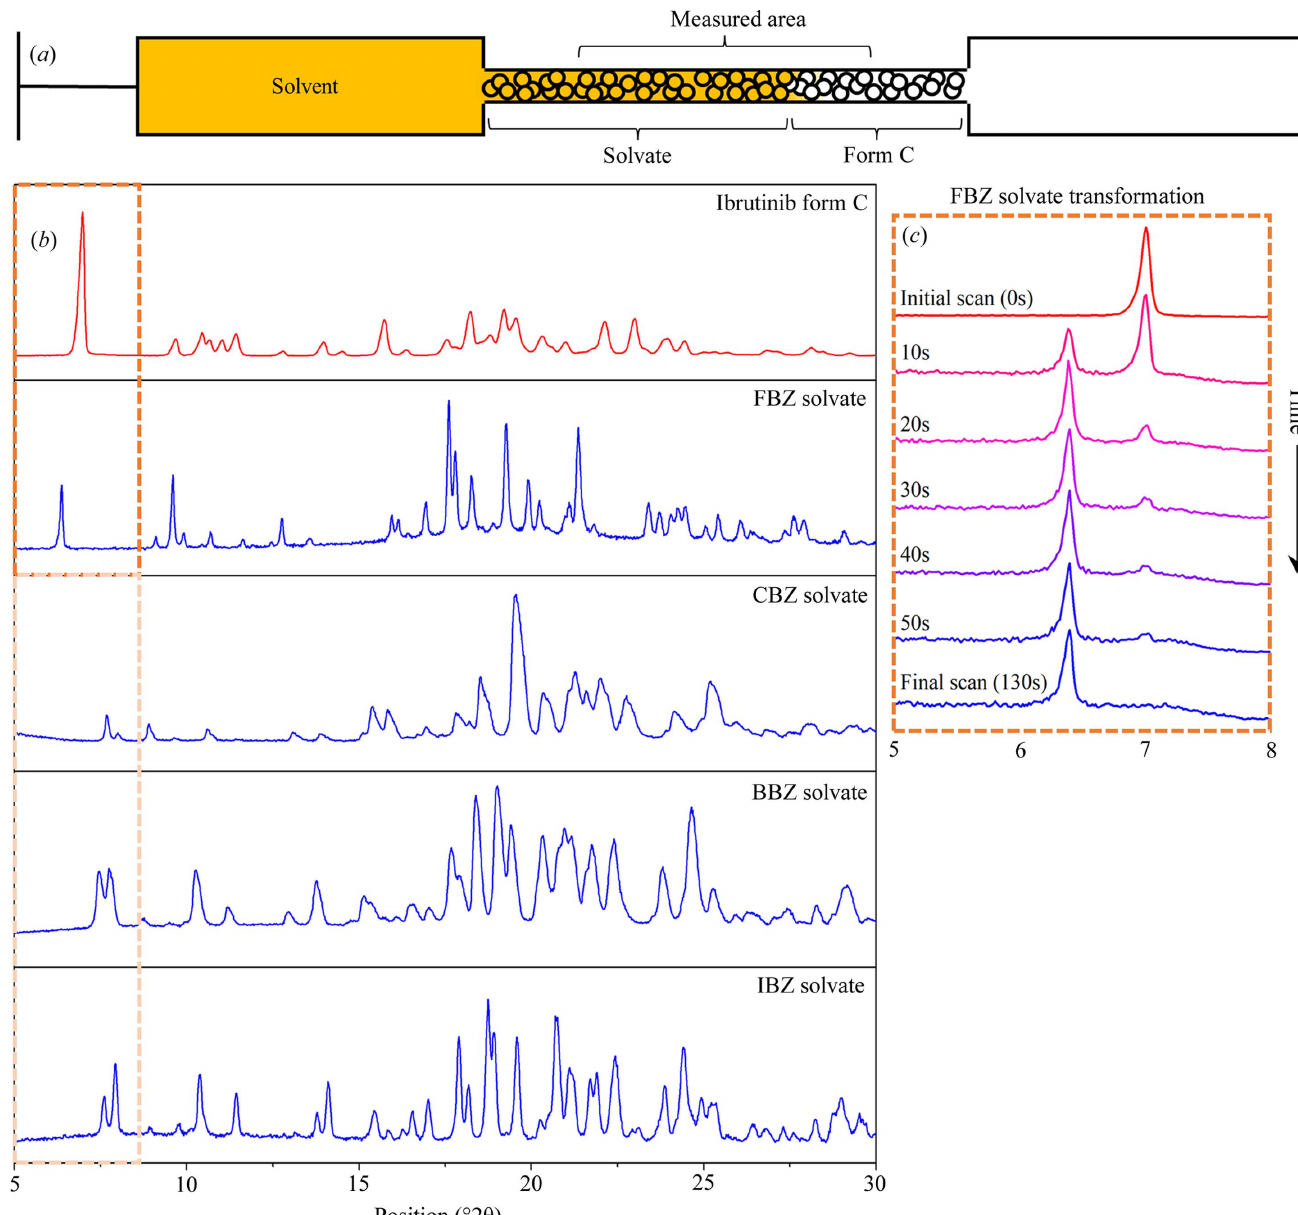
Figure 3 ( a ) Scheme of the glass flow-through capillary. ( b ) Diffraction patterns of ibrutinib polymorph C and of the prepared ibrutinib solvates. ( c ) Time series of diffraction patterns observed during the transformation of ibrutinib C to the FBZ